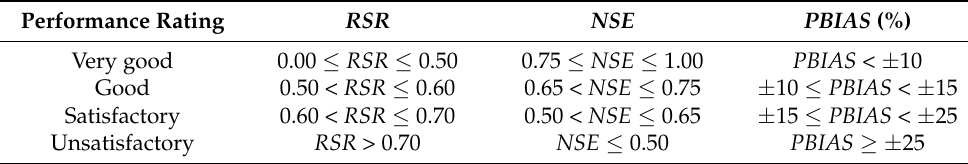
Table 2. General performance ratings for a hydrologic model